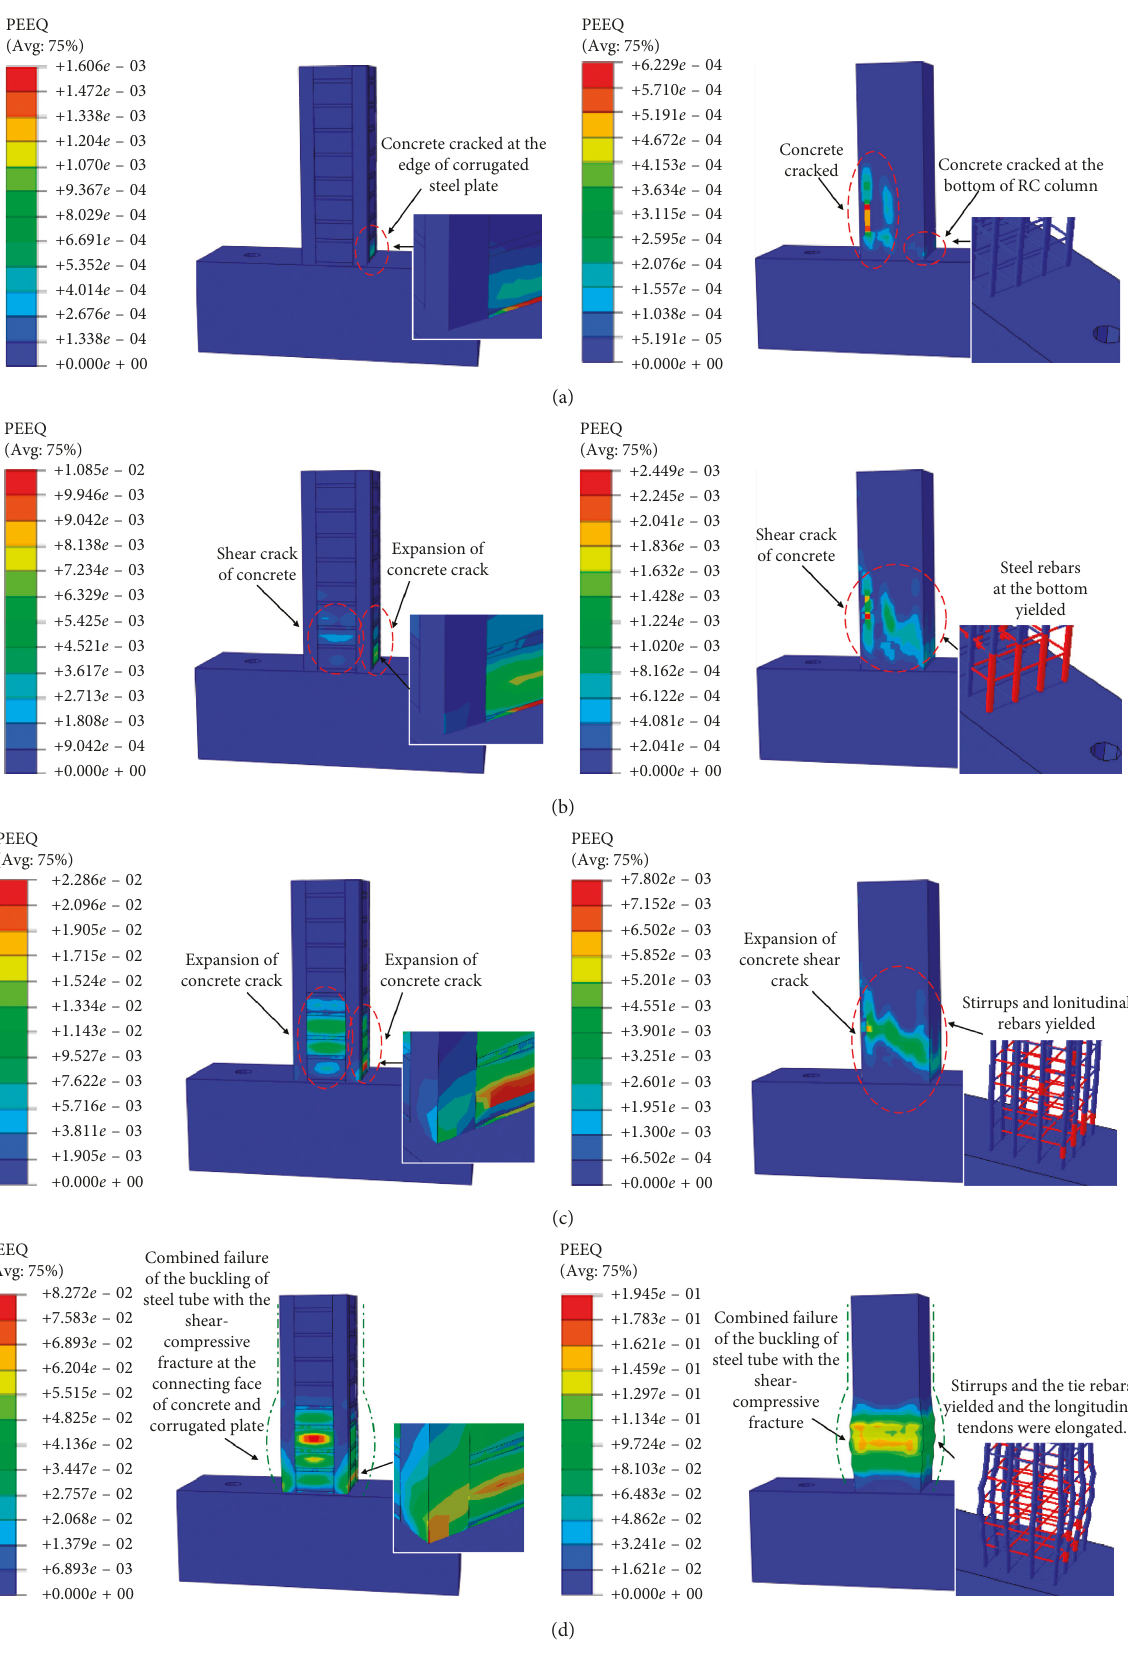
Figure 20: Strain contours and failure modes of ISSCC columns and RC columns. (a) Point A. (b) Point B. (c) Point C. (d) Point